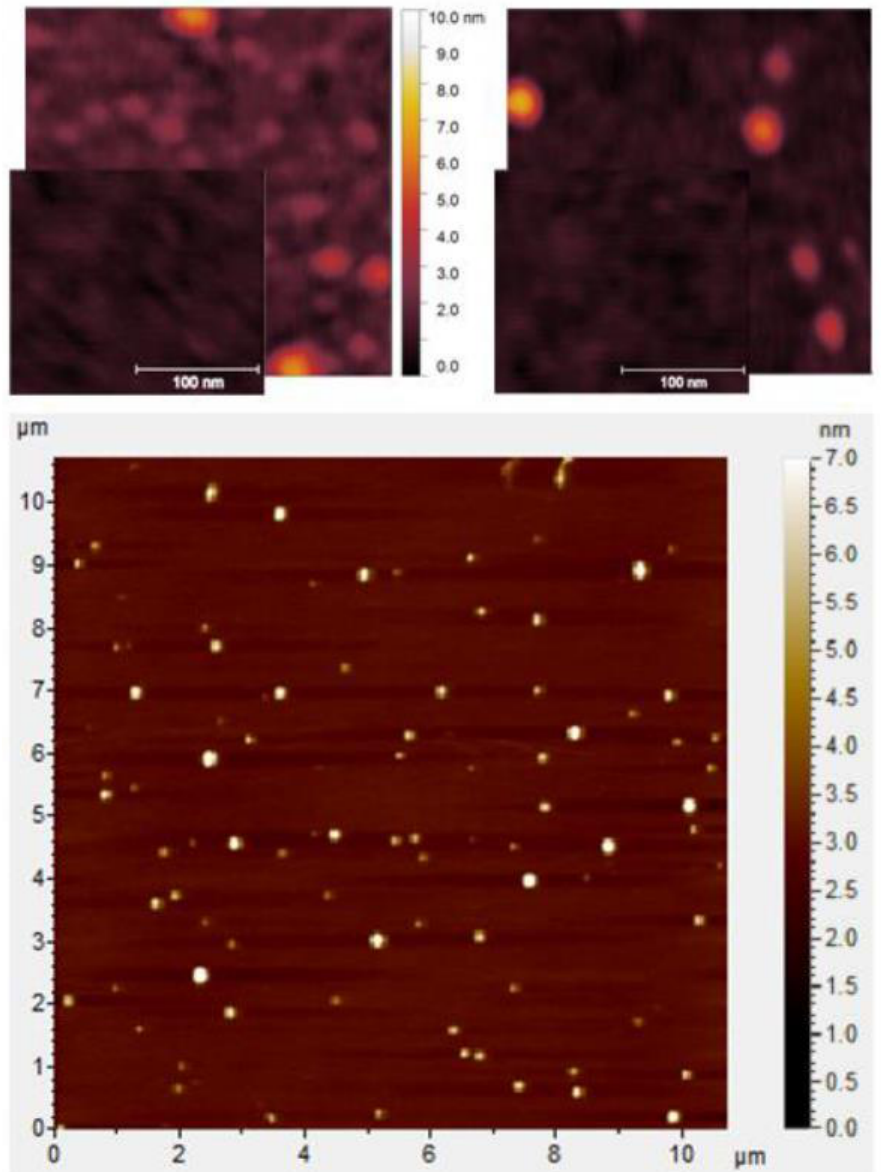
Figure 5. AFM images of NEC-CDots on silicon wafer (upper-right; inset: neat wafer) and on mica surface (lower) compared with those of the small carbon nanoparticles on silicon wafer (upper-left; inset: neat wafer). The upper images share the same height meter in the middle. NEC-CDots are sufficiently soluble in common deuterated organic solvents for more quantitative solution-phase proton and 13 C NMR measurements. Shown in Figure 6 is a comparison of the proton NMR results of NEC-CDots and free NEC molecules in DMSO- d 6 . The signals due to NEC protons in the dot sample are obviously broader, consistent with the attachment of NEC species to the small carbon nanoparticles for the protons in varying environments. Despite the broadness, the integrations for the two aliphatic peaks are in the ratio of about 1-to-3 for the protons on the α -carbon to those on the β -carbon, clearly different from the ratio of 2-to-3 in free NEC. The same integration of all aromatic protons in whole is about 8, namely close to the 8-to-3 ratio of all aromatic protons to those on the β -carbon in free NEC. These more quantitative NMR results, again despite the signal broadening effect on the carbon nanoparticle-attached NEC species, support strongly the notion that there must be hydrogen abstraction at the α -carbon in NEC molecules